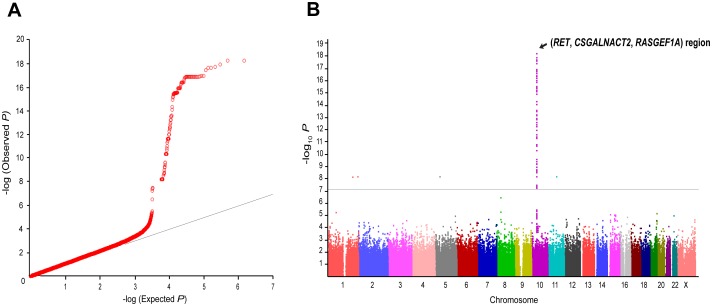
Overview of genome-wide association results.(A) Q-Q plot. The observed P-value (y-axis) is compared with the expected rawP-value (x-axis, under null distribution) before a Bonferroni correction. (B) Graphical summary (Manhattan plot) presenting rawP-values for the association with HSCR in 123 sporadic HSCR patients and 432 unaffected controls. The −log10
P (logistic regression analysis) is plotted against its physical position on successive chromosomes. Gray line represents the threshold for GWAS significance after a Bonferroni correction.